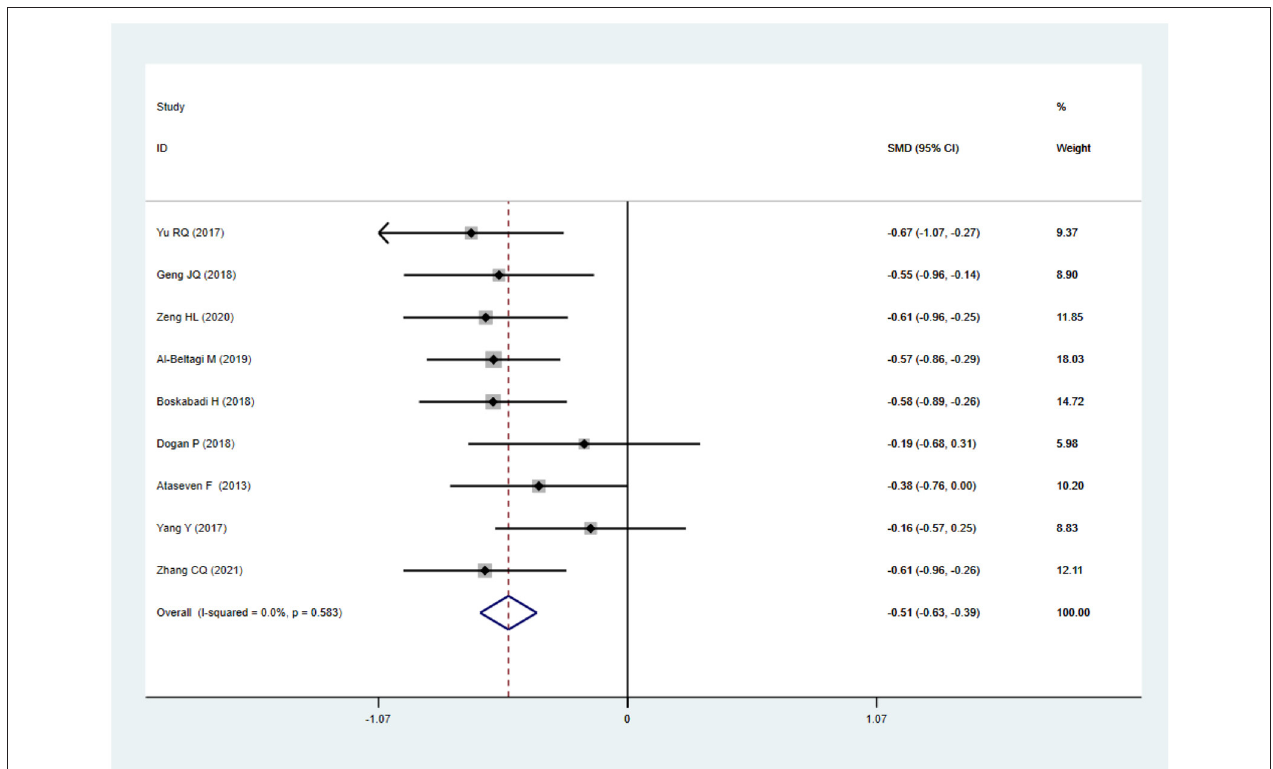
FIGURE 2 | Meta analysis of the difference of 25(OH)D level between the two groups.